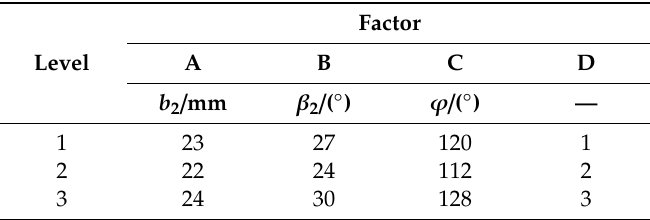
Table 7. Level of factors in orthogonal experiments.